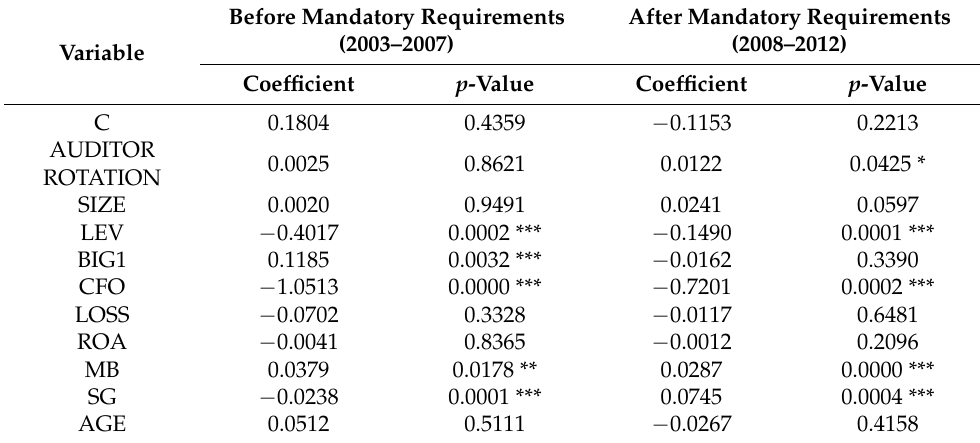
Table 6. The results of the first